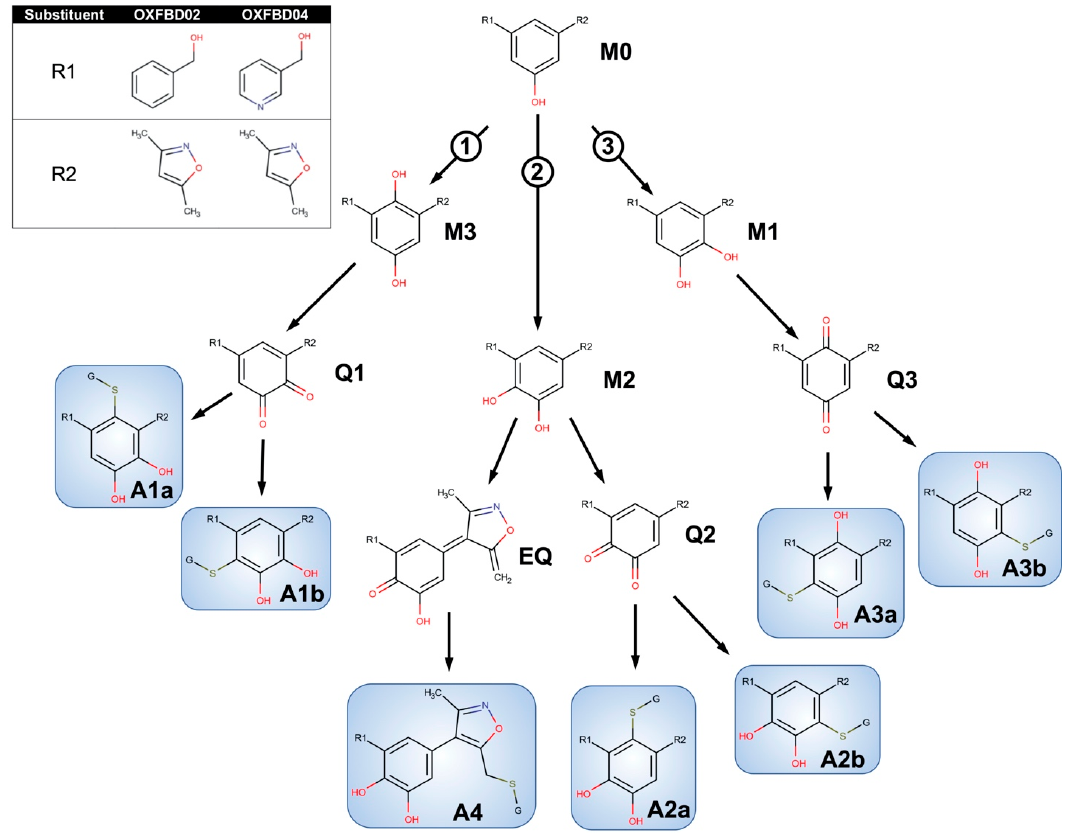
Figure 3. Competing bioactivation pathways for OXFBD series of BET inhibitors. OXFBD02 ′ s and OXFBD04 ′ s bioactivation pathways require an initial hydroxylation of the internal phenyl group. The three potential sites give rise to three competing pathways, as indicated by circled numbers. Pathways 1 and 2 show hydroxylations yielding an ortho -hydroquinone. Pathway 1 leads to an ortho -quinone and a subsequent pair of glutathione adduct isomers (A1a and A1b). In contrast, Pathway 2 bifurcates, leading to either an ortho -quinone and a pair of glutathione adduct isomers (A2a and A2b), or a single glutathione adduct arising from an extended quinone-methide involving the isoxazole (A4). Pathway 3 involves an initial formation of a para -hydroquinone followed by a para -quinone trapped into a pair of glutathione adduct isomers (A3a and A3b). Analysis of adducts then yields characteristic patterns for pairs of quinones except for the extended quinone in which there is one possibility.